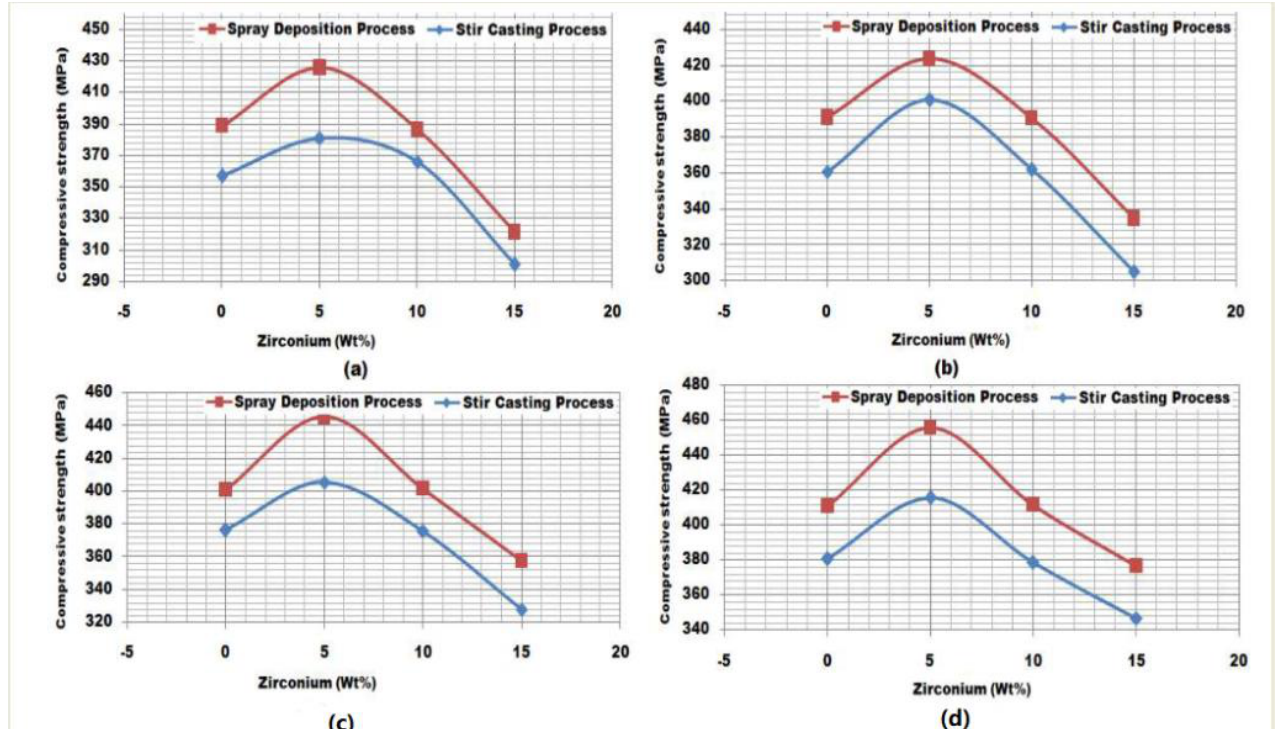
Figure 14. Compressivestrength (0.05% error) experimental plot at different processing techniques of Si-Al alloy matrix reinforced with ZrO 2 particulates for ( a ) 10% ( b ) 11% ( c ) 12% ( d ) 13 wt.% Si.